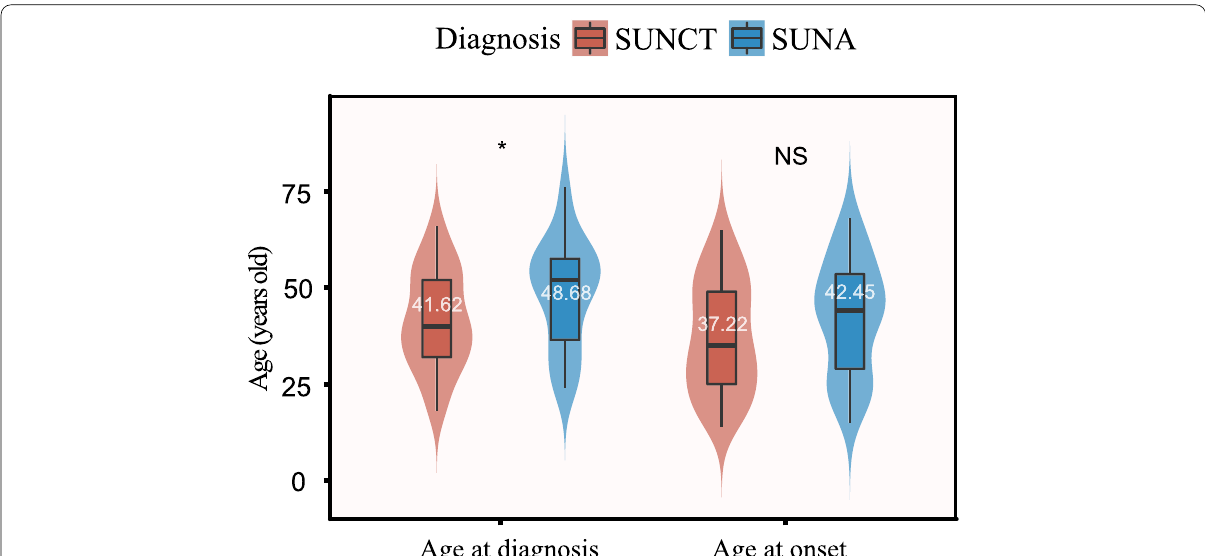
Table 2 Attack triggers in patients with SUNCT ( n